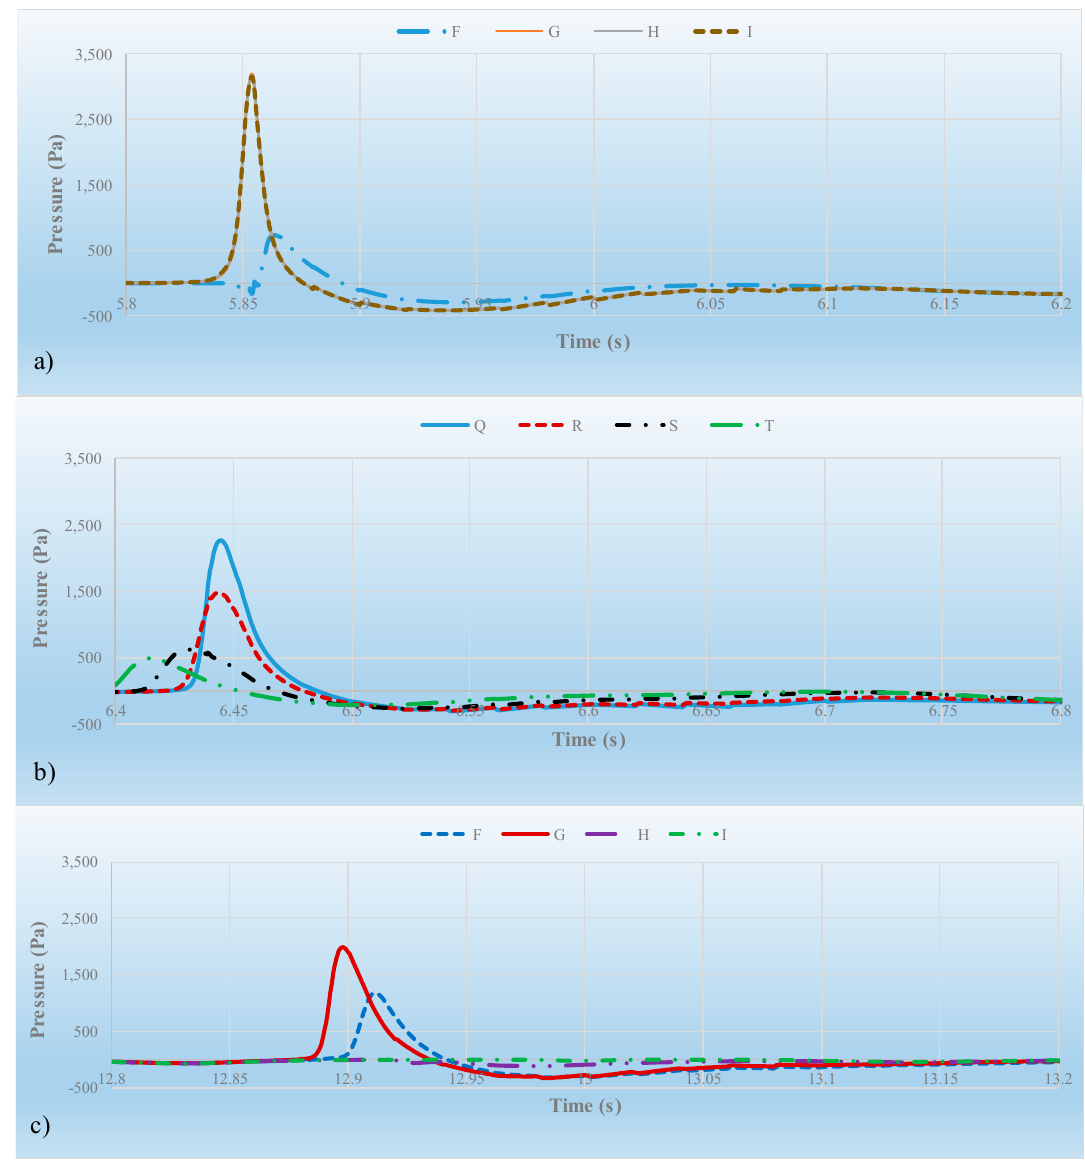
Figure 14. Comparison of pressure distributions for the tank with 200 mm water depth excited by the N-S component of the El Centro earthquake at: ( a ) 0°, ( b ) 30°, and ( c ) 60° orientations.